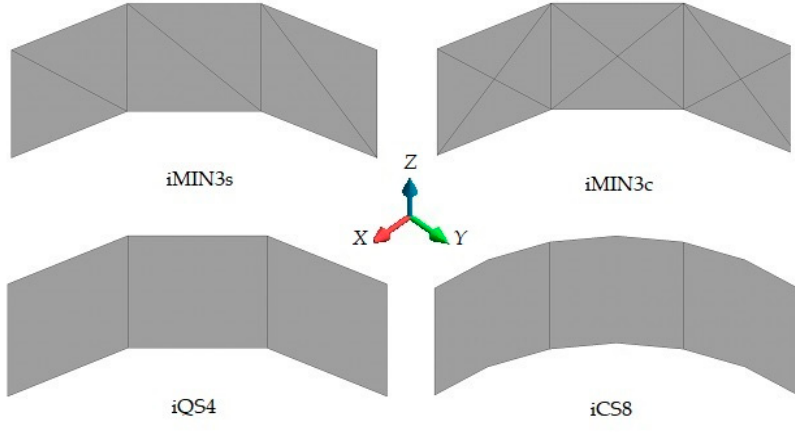
Figure 7. Mesh resolution of 3 × 1 for the curved plate using four different discretization strategies.